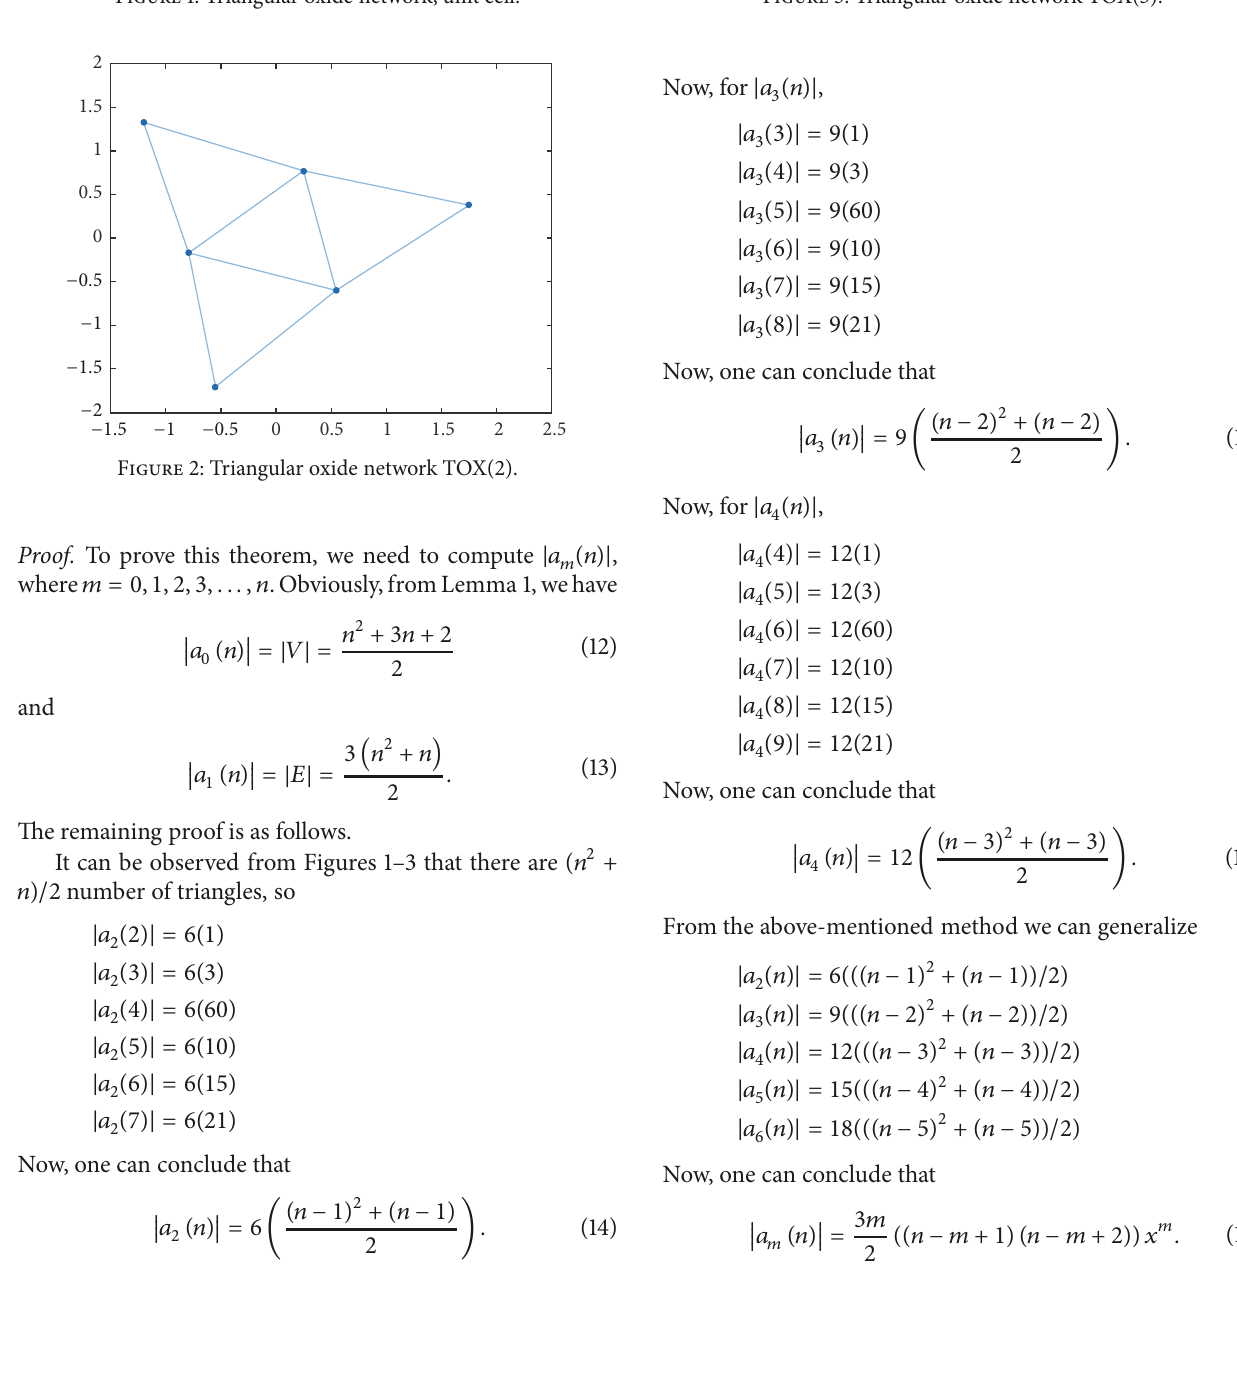
Figure 1: Triangular oxide network, unit cell.